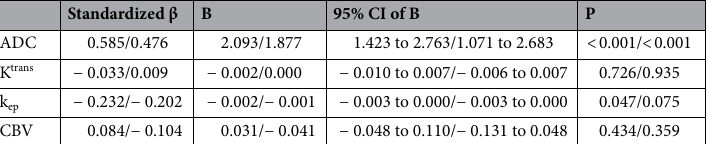
Table 3. Multiple regression analysis examining associations between APTSI and diffusion/perfusion imaging parameters. Values for observer 1/observer 2 are shown for each